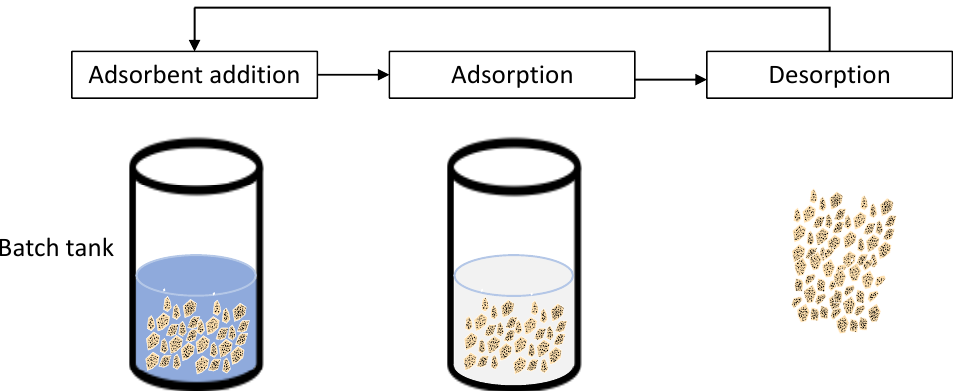
Figure 14. Typical setup for pollutant removal via batch adsorption [64].